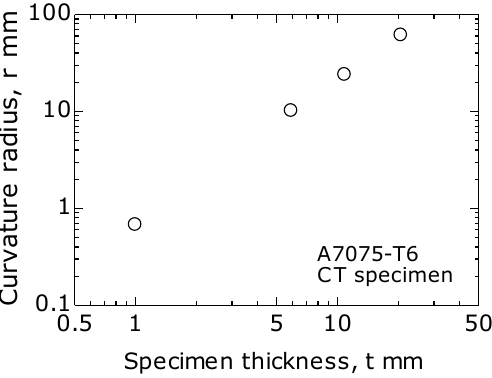
Figure 10. Relationship between curvature radius r and t . ∆ K = 12 MPa · m 1/2 .